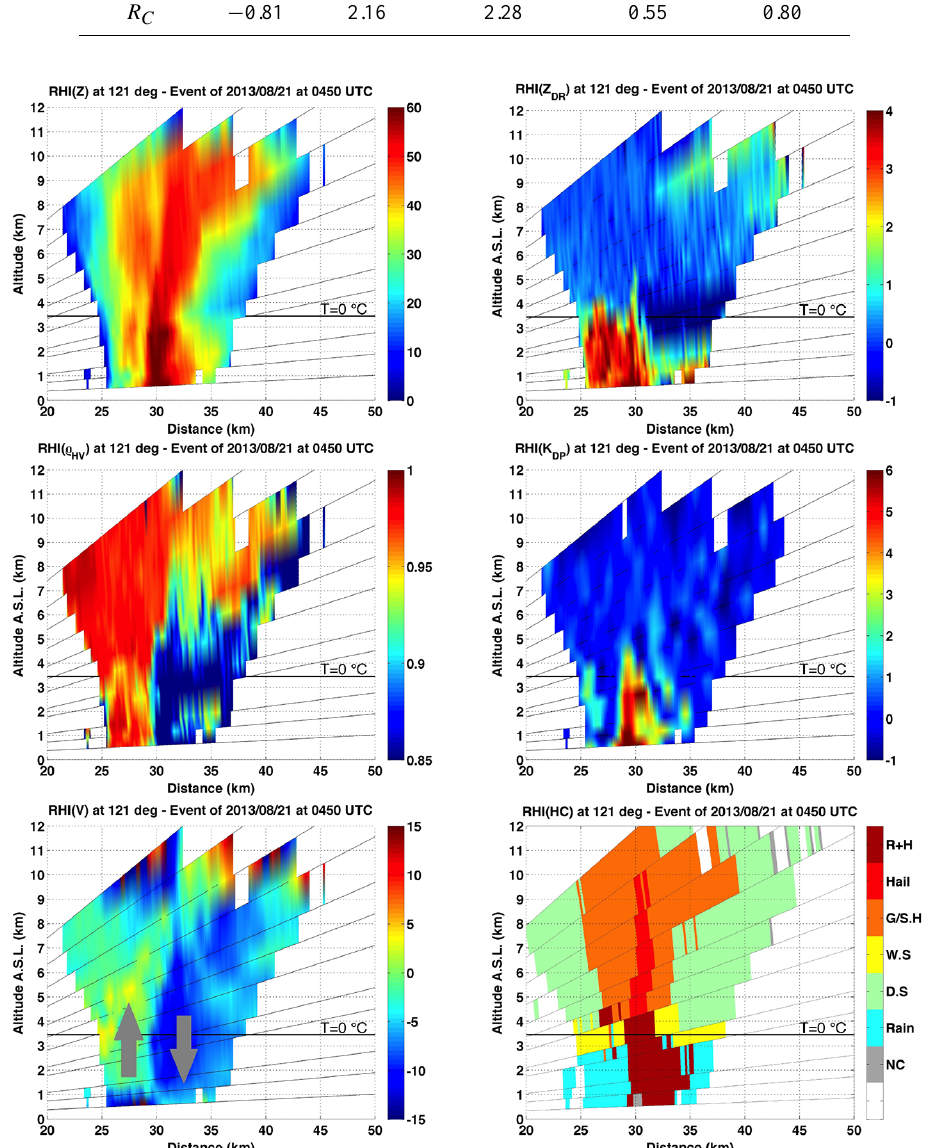
Figure 12. Vertical cut of Z H (upper left panel), Z DR (upper right panel), ρ HV (middle left panel), K DP (middle right panel), radial velocity (lower left panel) and hydrometeor classes (lower right panel) taken at 121 ◦ of azimuth on 21 August 2013 at